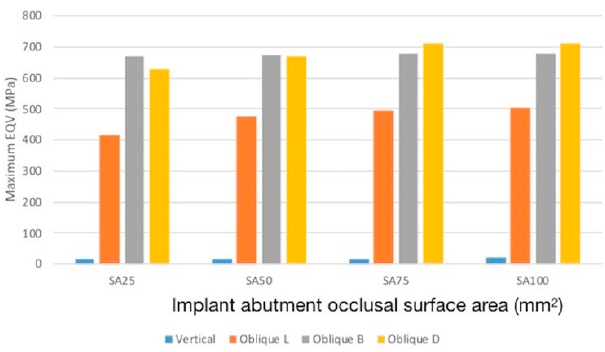
Figure 8. Comparison of maximum von Mises (EQVs) in zirconia specimens on four implant abutment designs (SA25, SA50, SA75, and SA100) under vertical (300 N), oblique L, oblique B, and oblique D directions. Lowest value occurred in the zirconia specimen with the implant occlusal surface of SA25. Oblique L means oblique 10-degree 300 N loading applied on a lingual marginal ridge of zirconia specimen. L means lingual. B means buccal. D means distal.